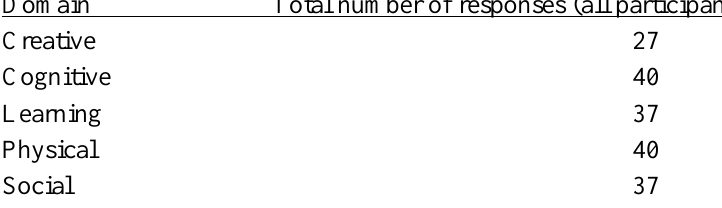
Daily Activities Distribution by